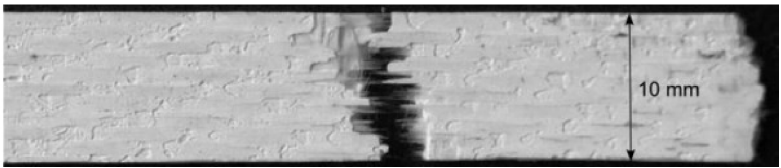
Figure 1. ( left ) The porous matrix of the OCMC FW12. ( right ) Weak matrix concept resulting from the porous matrix, according to Levi et al. [10].